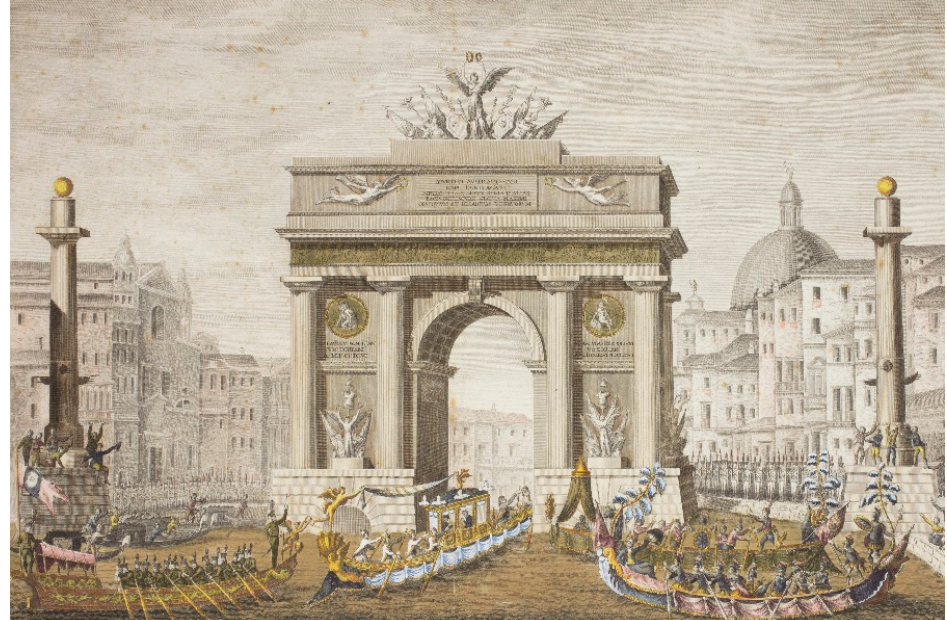
Figure 8. Anonymous, Napoleon’s entry into Venice, watercolor etching, 1807, Palazzo Ducale, Venice.